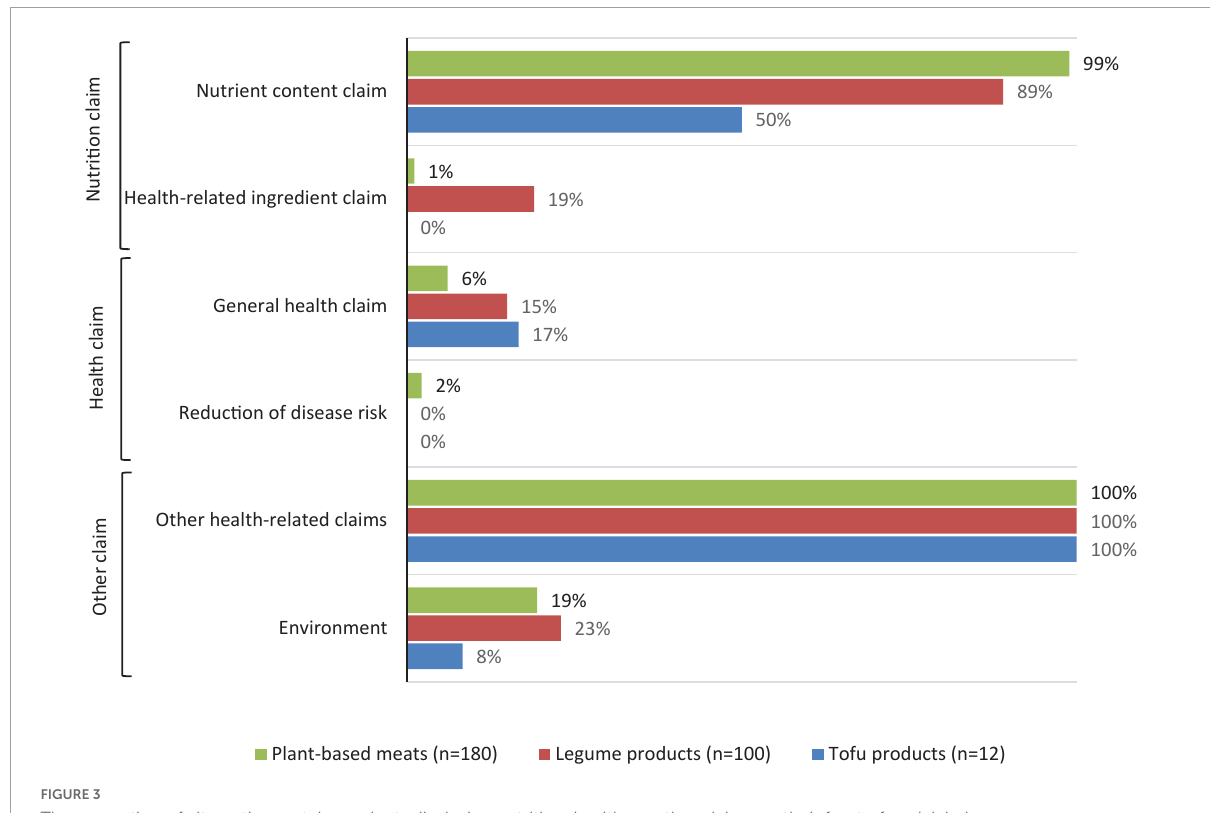
FIGURE3 The proportion of alternative protein products displaying nutrition, health, or other claims on their front of pack